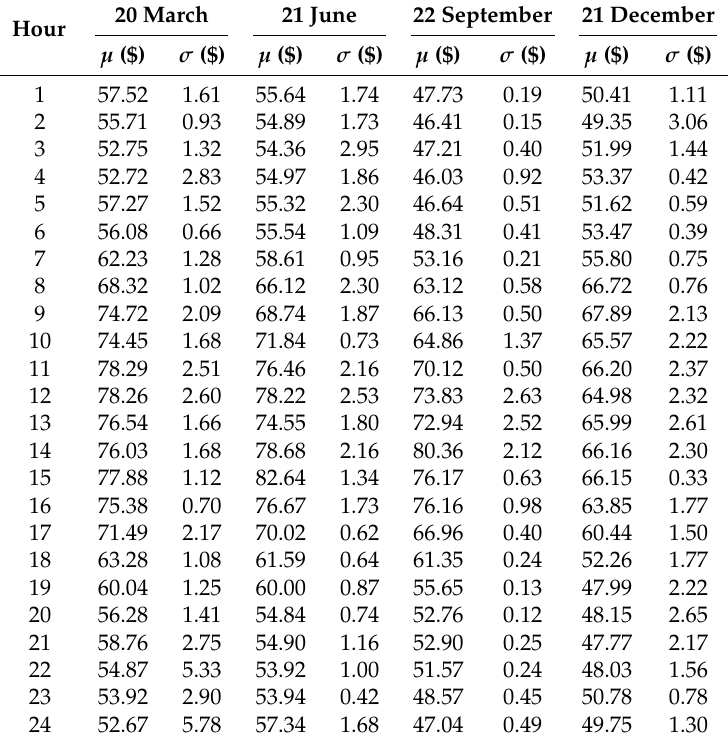
Table 5. Hourly operating costs (mean and standard deviation) on four example days.